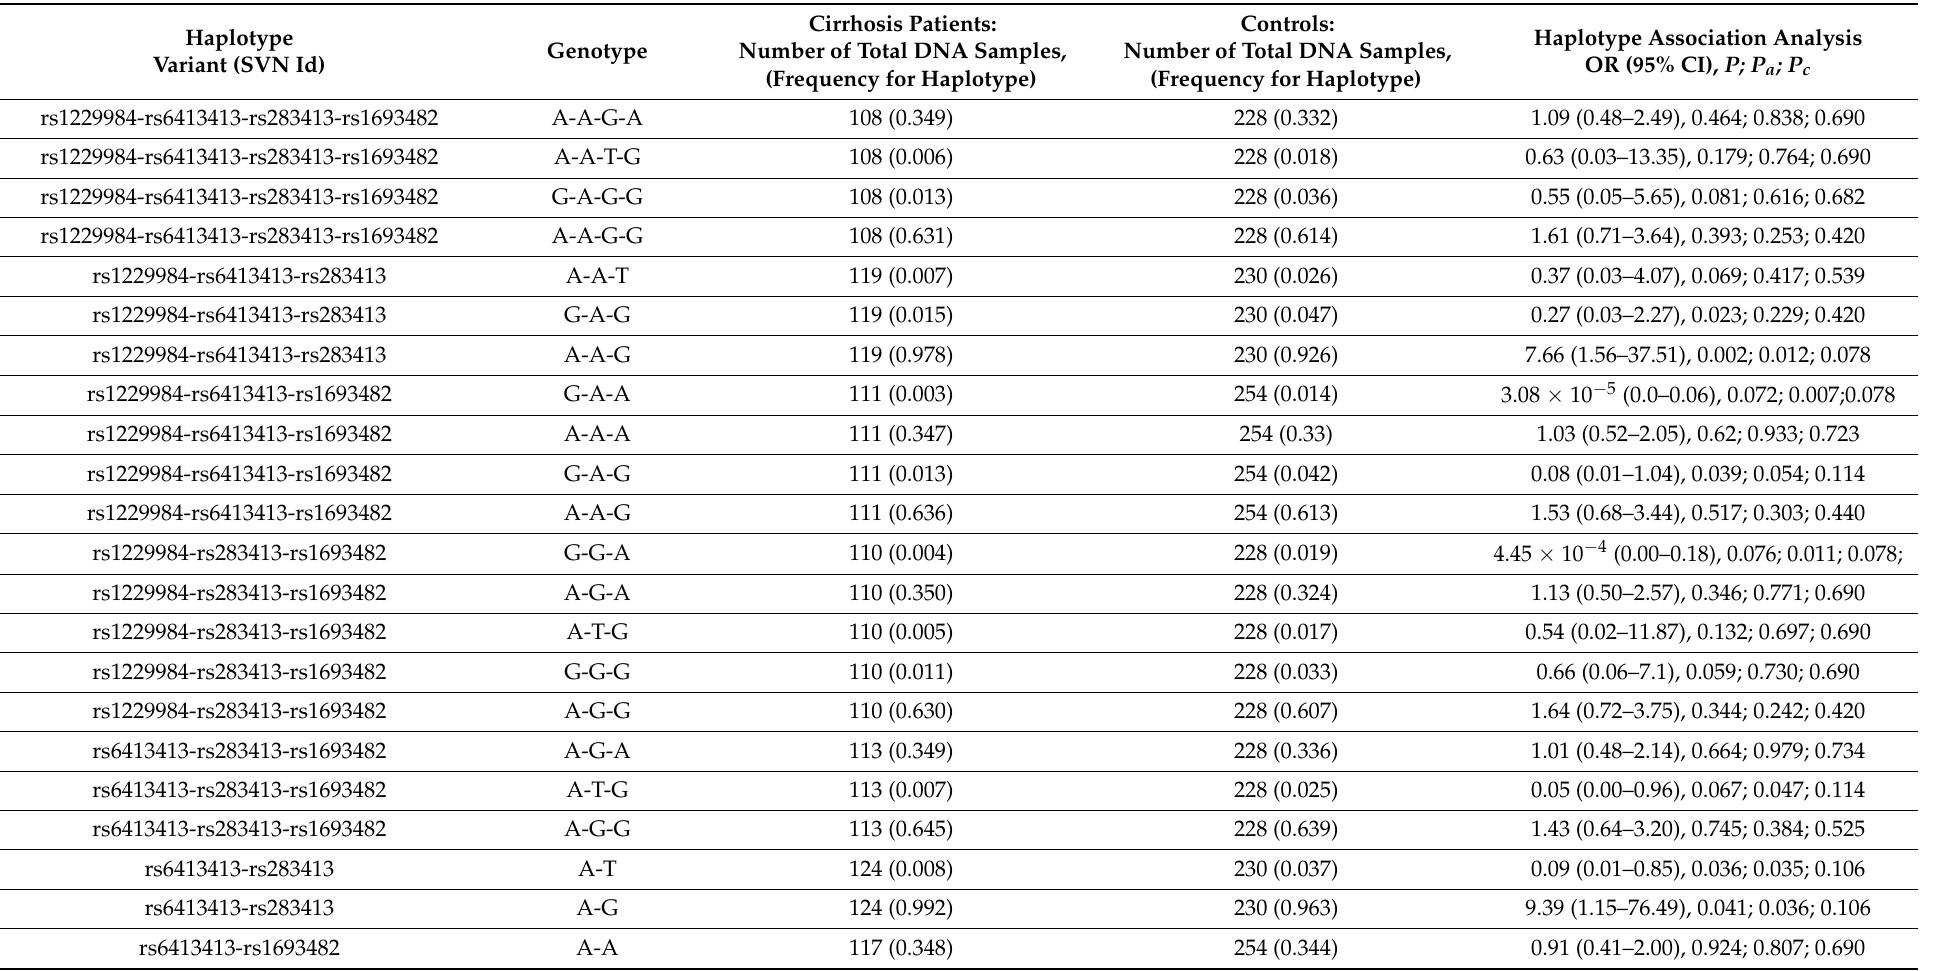
Table 5. Alcohol dehydrogenase haplotypes in patients with alcoholic liver cirrhosis and healthy